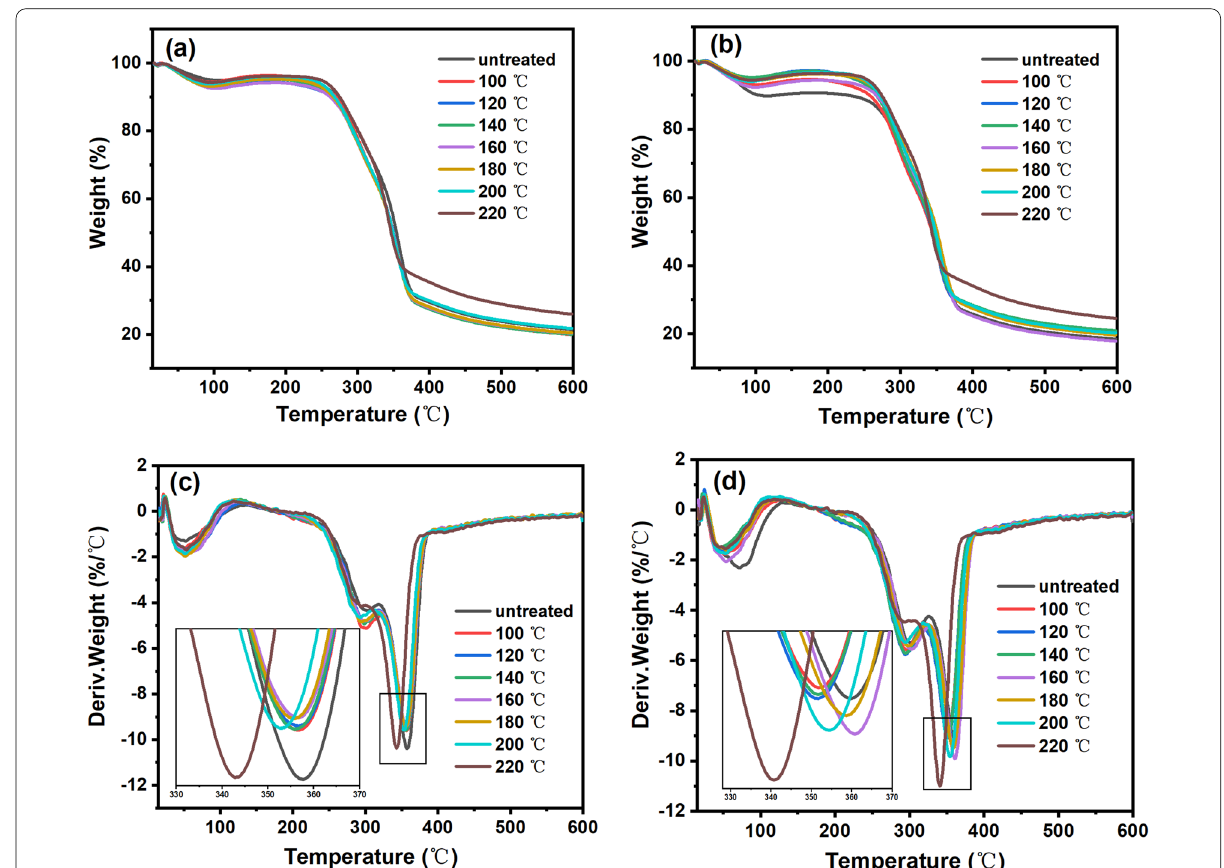
Fig. 10 Typical TGA curves of a fibers and b parenchyma cells, DTG curves of c fibers, and d parenchyma